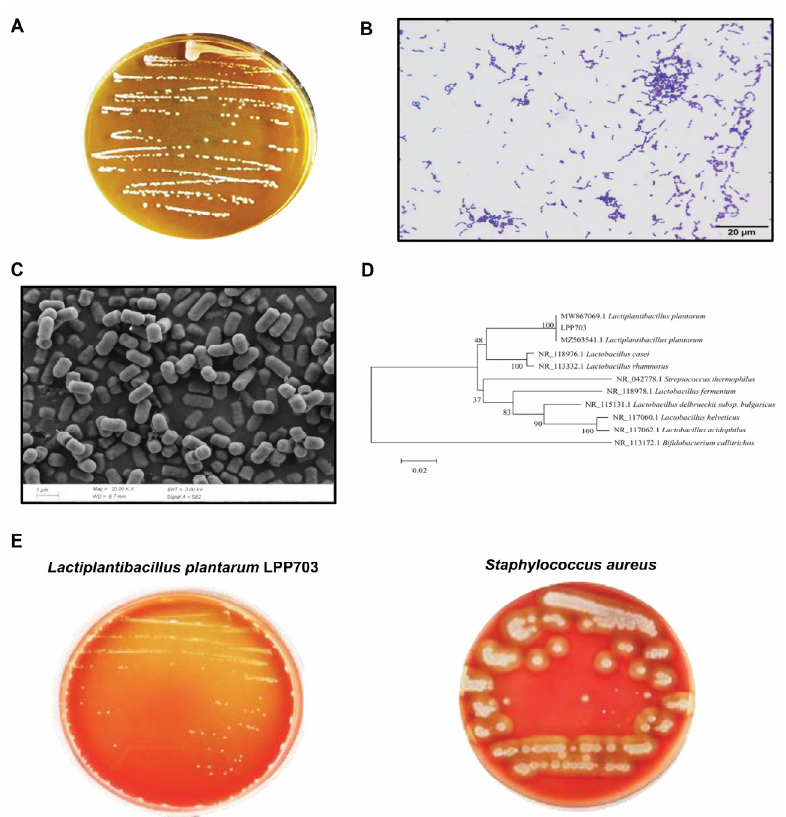
Figure 1. Morphology, identification, and safety analysis of the Lactiplantibacillus (Lpb.) plantarum LPP703 strain. ( A ) Colony morphology of Lpb. plantarum LPP703. ( B ) Gram staining of Lpb. planta- rum LPP703. ( C ) Scanning electron microscopy image of Lpb. plantarum LPP703. ( D ) Neigh- bor-joining phylogenetic tree of Lpb. plantarum LPP703. ( E ) Hemolytic test of Lpb. plantarum